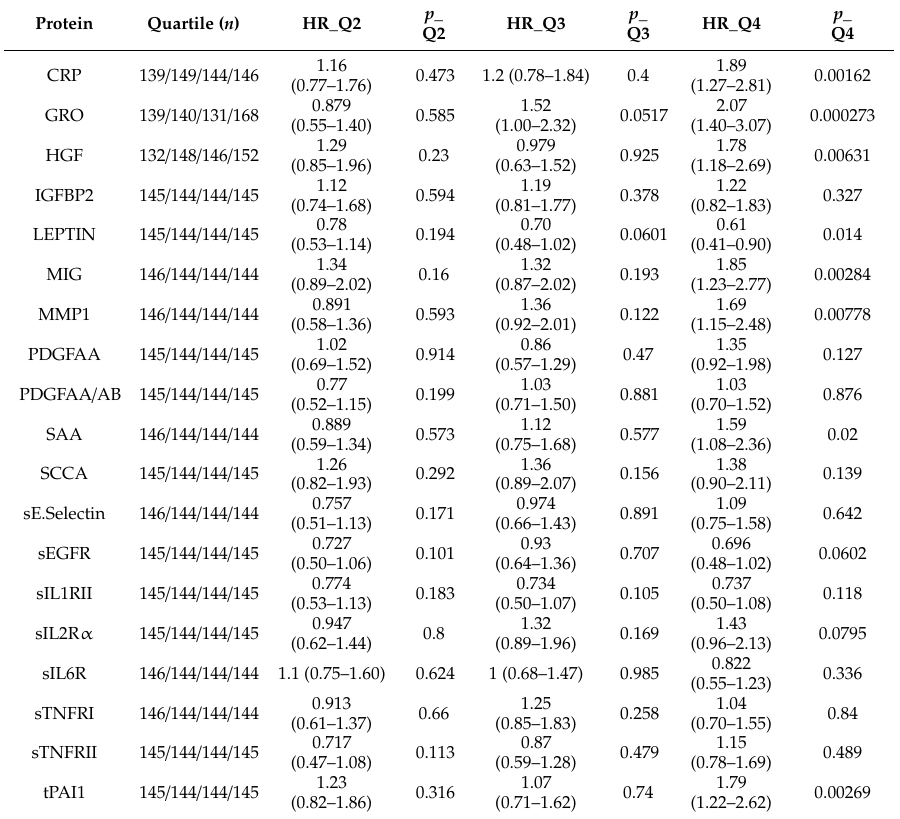
Table 2. Cox proportional hazards ratio (95% CI) for individual proteins after adjusting for stage and treatment as